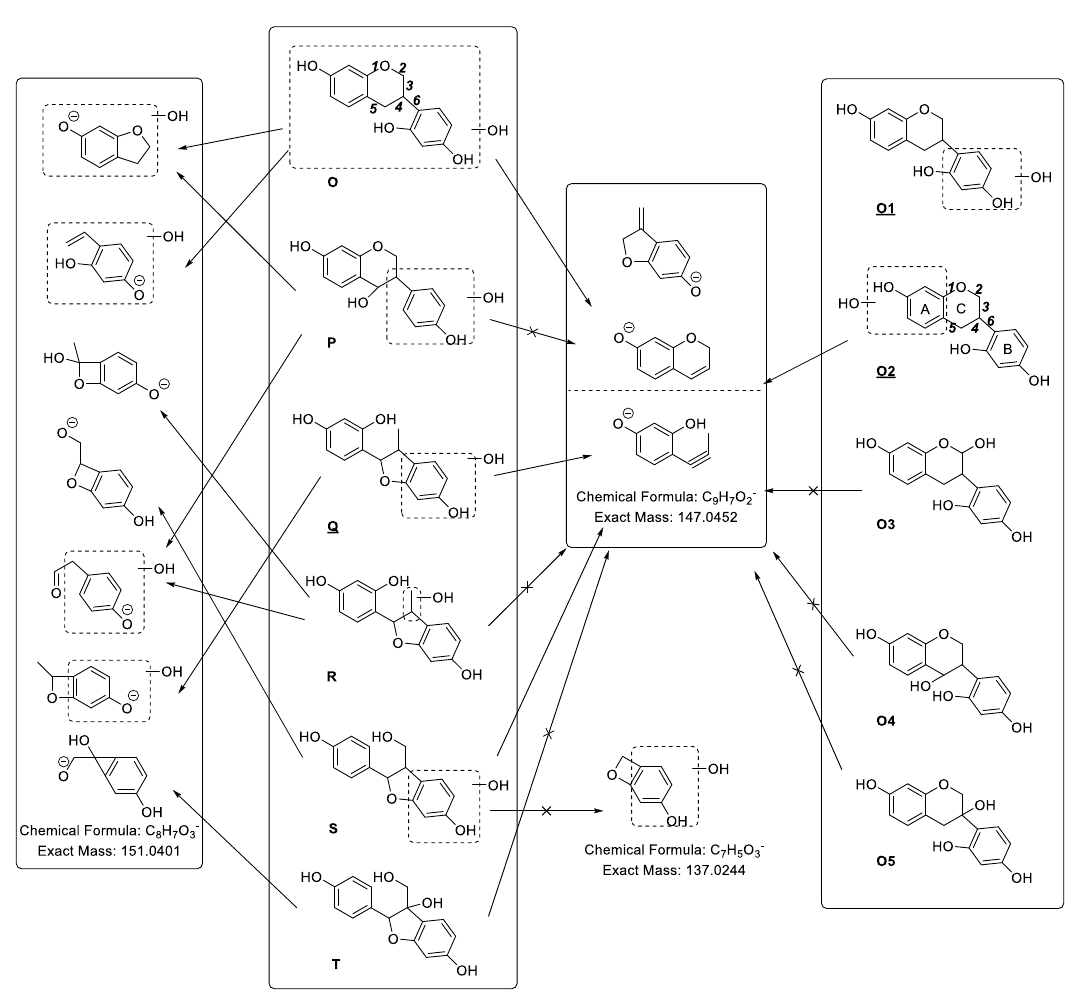
Figure 12. The probable structures ( O1 , O2 , Q ) of the aglycon of M144 .